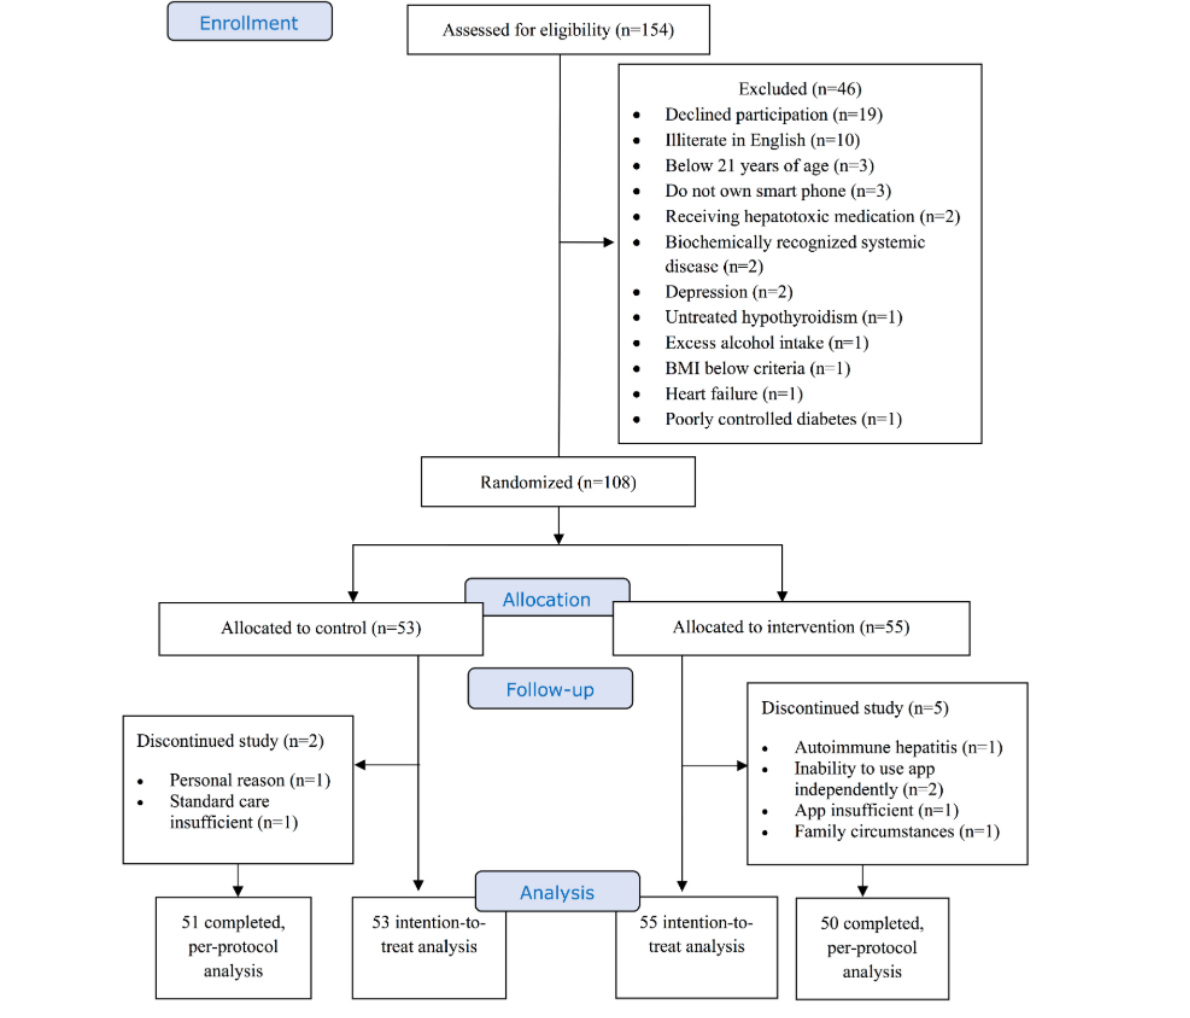
Figure 2. Consolidated Standards of Reporting Trials (CONSORT) study flow diagram. BMI: body mass